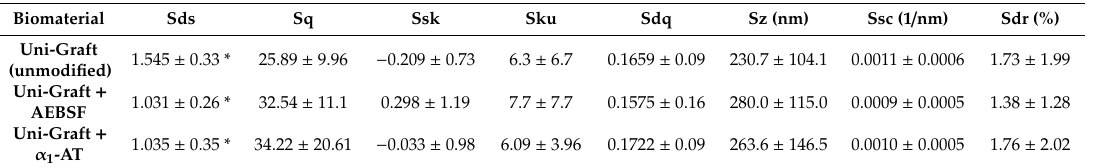
Table 5. Summary of values for characteristic parameters describing the morphological structure of the examined biomaterials; n = 20.